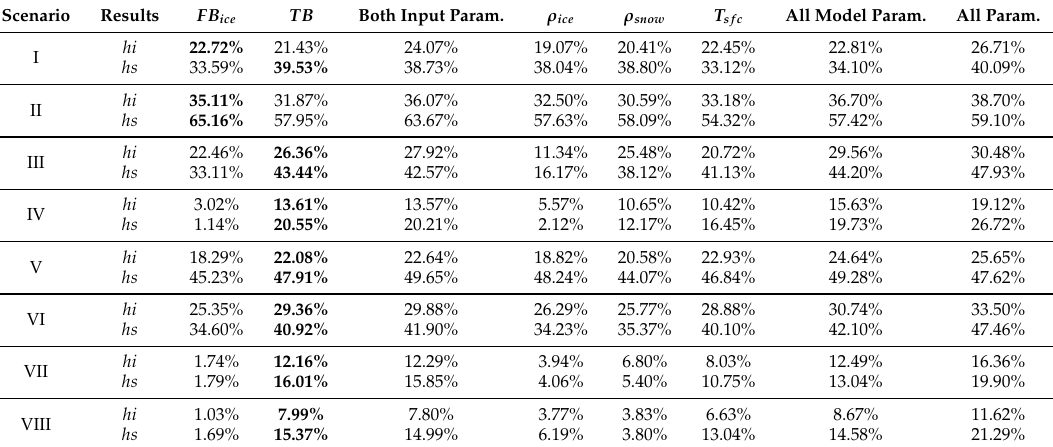
Table 7. Same as Table 5 but for the data synergy between TB and FB snow